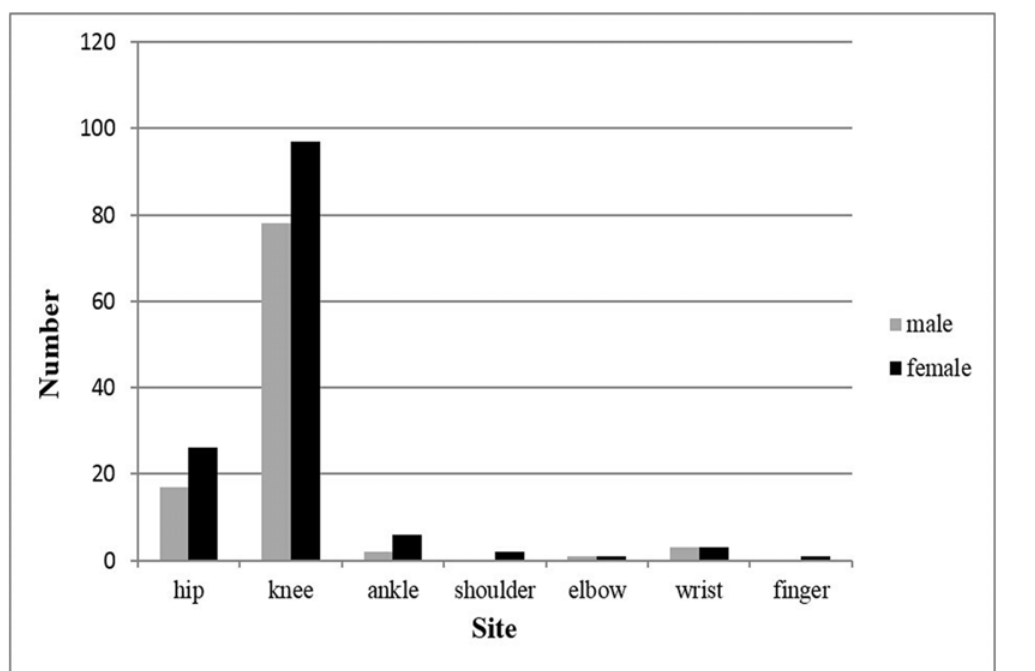
Fig 4. Anatomical distribution of 237 PVNS patients by gender. doi:10.1371/journal.pone.0121451.g004 were the knee (3 cases), the hip (1 case) and the wrist (1 case). The surgical procedures included single femoral condylar replacement (1 case), total hip arthroplasty (1 case), plate fixation for bone fracture (2 cases) and wire fixation for reconstruction of anterior cruciate ligament (1 case). The detailed information for these patients was revealed in Table 3.